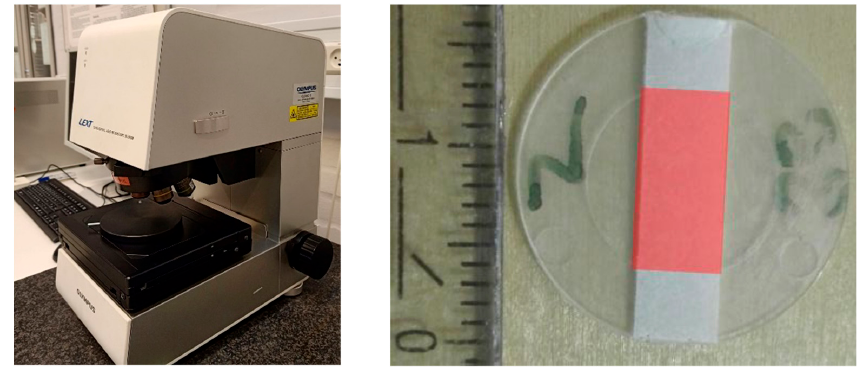
Figure 4. Olympus LEXT OLS 4000 3D measuring laser microscope used for the analysis ( left ), Measurement area of 5 × 10 mm² on the membrane in the center of the part—red area ( right ).